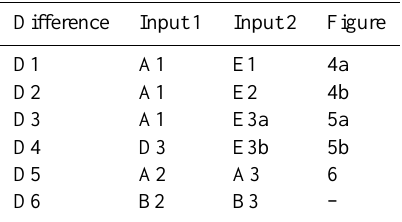
Table 3. Overview on the calculated differences. For each differ- ence input 2 is subtracted from input